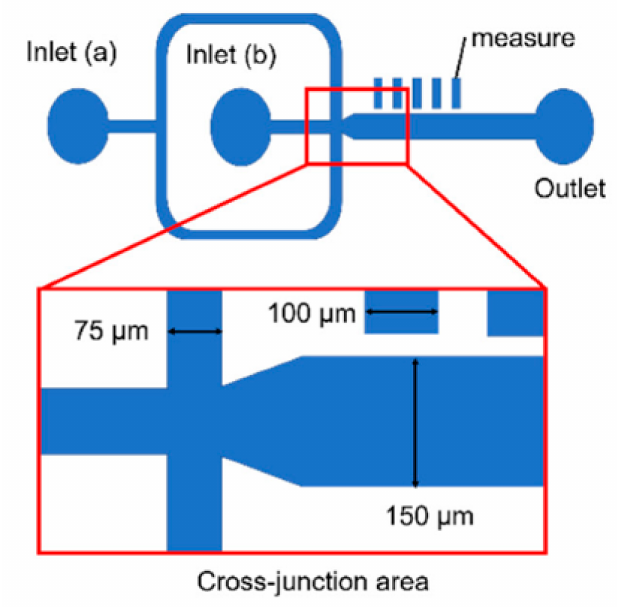
Figure 28. Schematic diagram of channel design for the droplet generation device used by Hattori et al. The widths of the main channel and inlet channels were 150 and 75 µ m, respectively, and the channel depth was 100 µ m. Reprinted from an open-access source